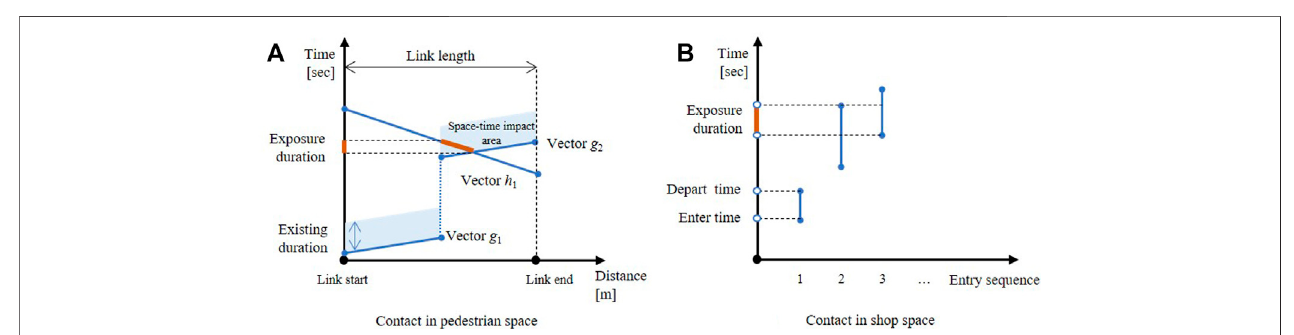
FIGURE 6 | Inter-individual contact in the space-time coordinate system: (A) contact in pedestrian space; (B) contact in shop space.